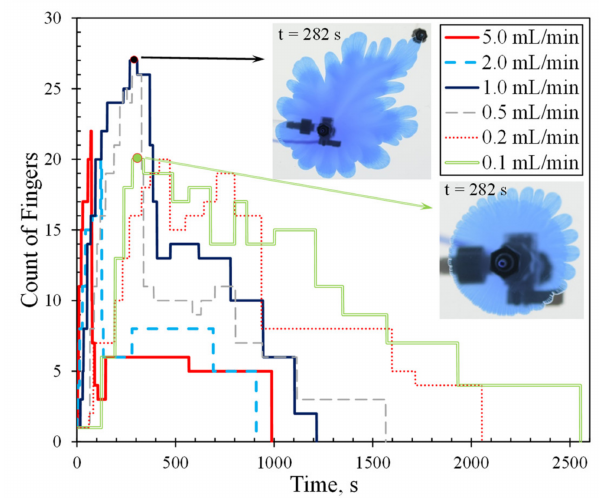
Figure 12. Count of fingers with time at different flow rates with the control of constant production rate at the outlet (two-pump